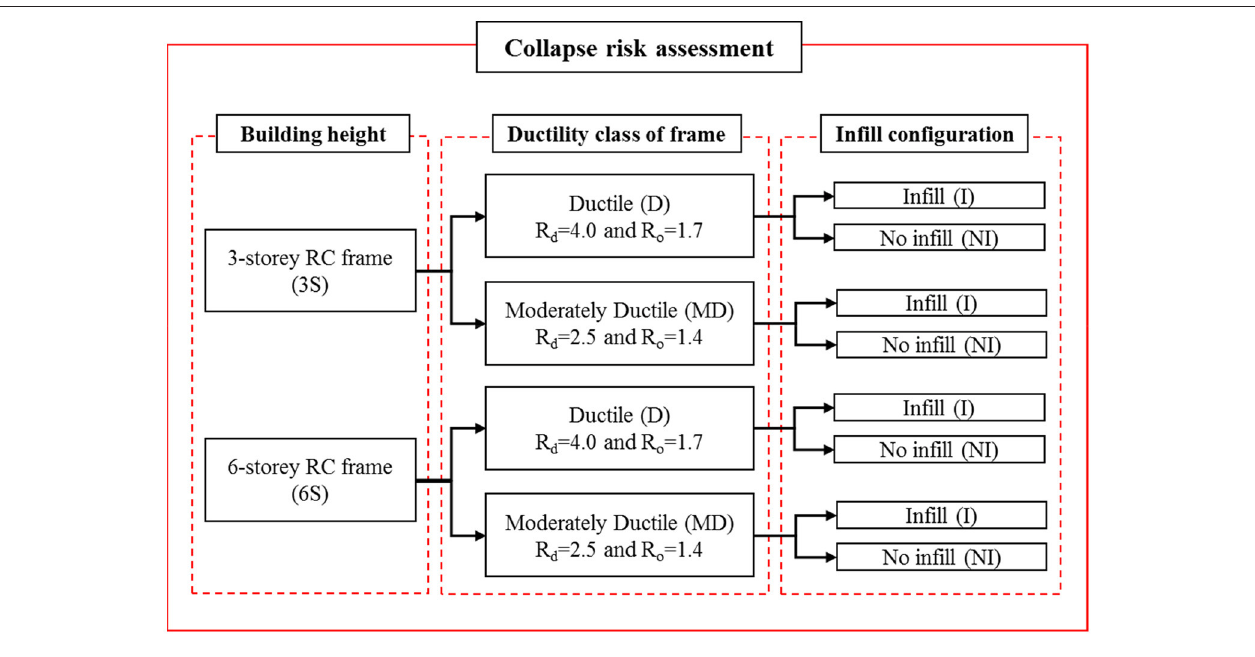
FIGURE 1 | Collapse risk assessment of RC frame